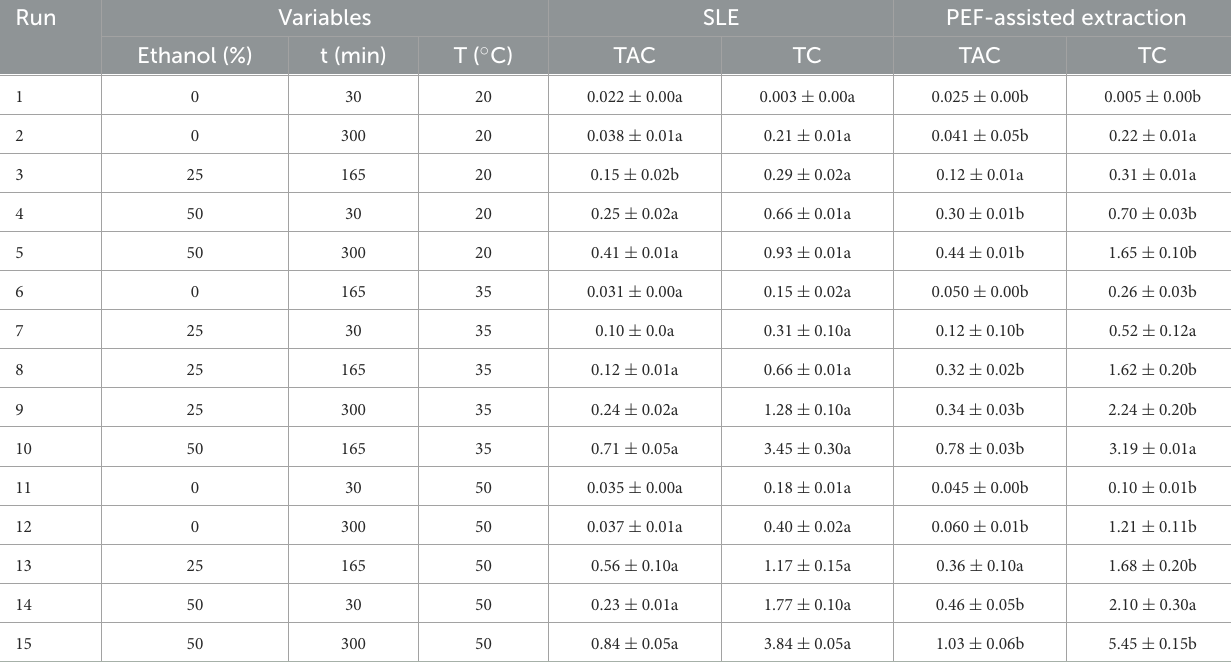
TABLE 3 Effect of the independent factors investigated on the response variables (TAC, TC) in grape pomace extracts from untreated and PEF (4.6 kV/cm, 20kJ/kg)-treated samples. Run Variables SLE PEF-assisted